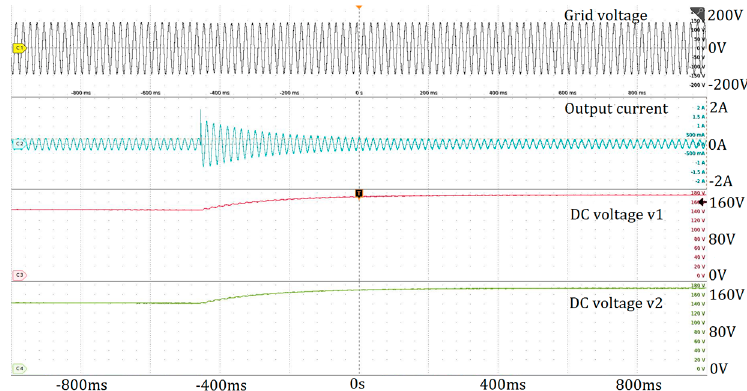
Figure 12. Responses of the inverter in master mode when the DC voltages are maintained at desired value.